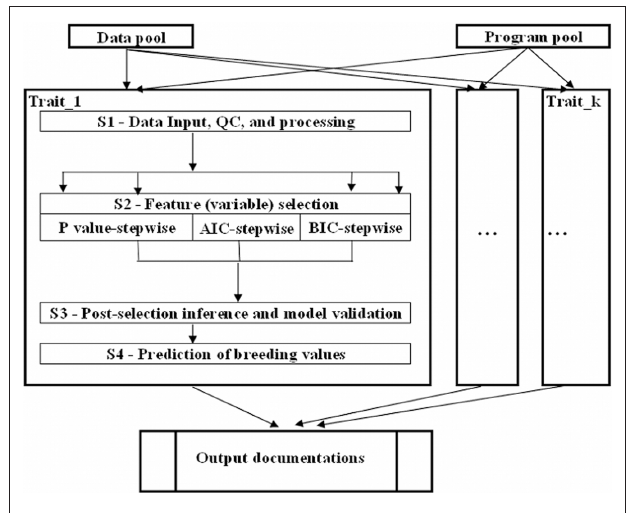
FiGure 5 | Workflow of a high-throughput computing pipeline for predicting genetic merit using candidate gene panels.